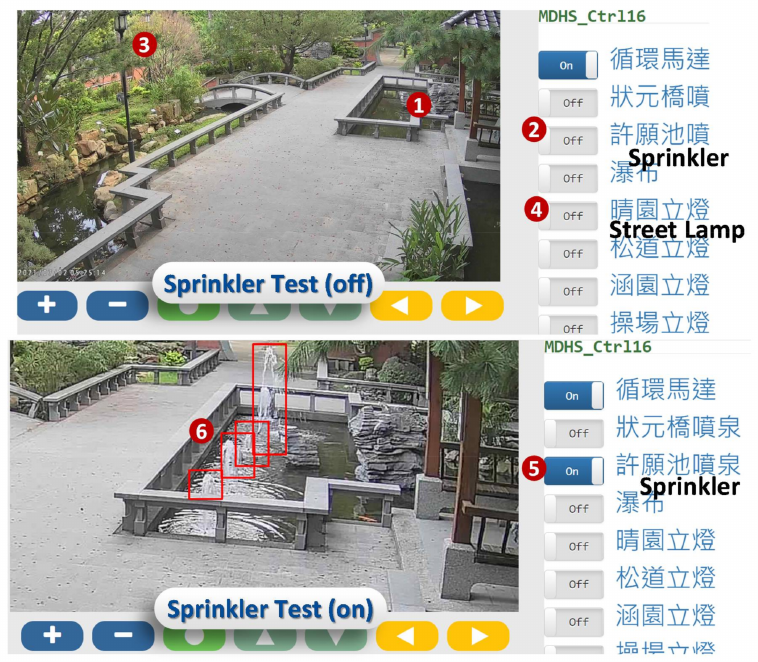
Figure 22. The fountain in the Ming Der High School,